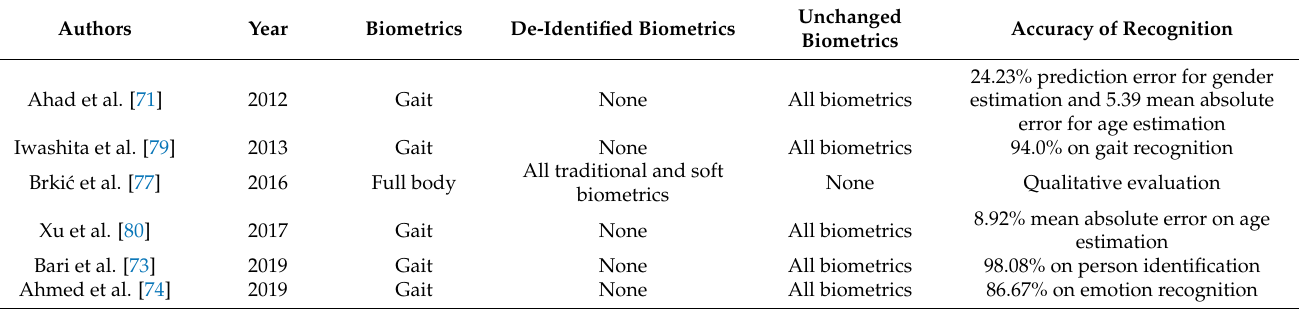
Table 5. Summary of sensor-based identification and de-dentification